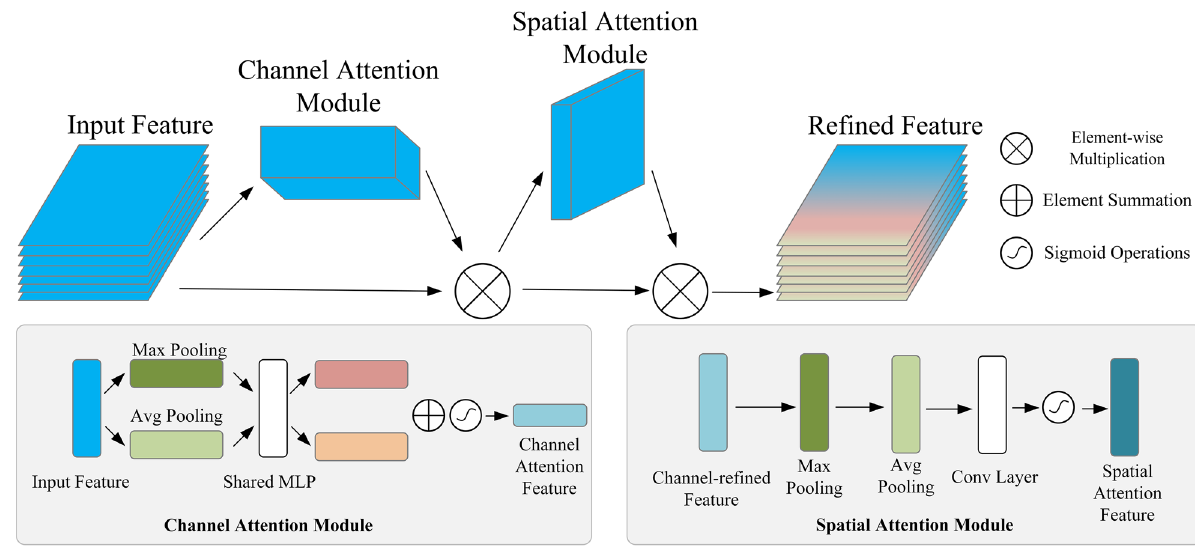
Figure 3. The structure of the CBAM attention